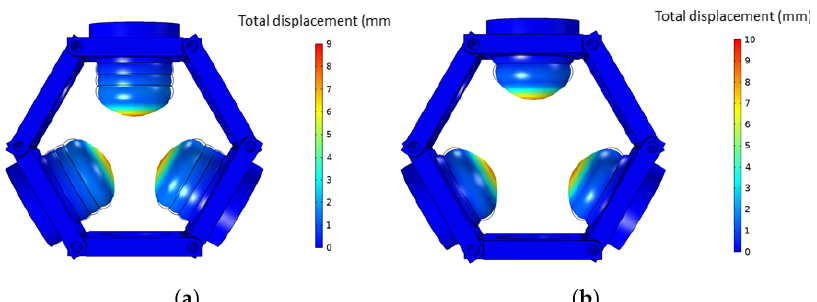
Figure 3. Model showing the displacements reached on the actuators of the soft gripper with hexago- nal configuration under constant pressure: ( a ) 4-bellows soft actuator; ( b ) 2-bellows soft